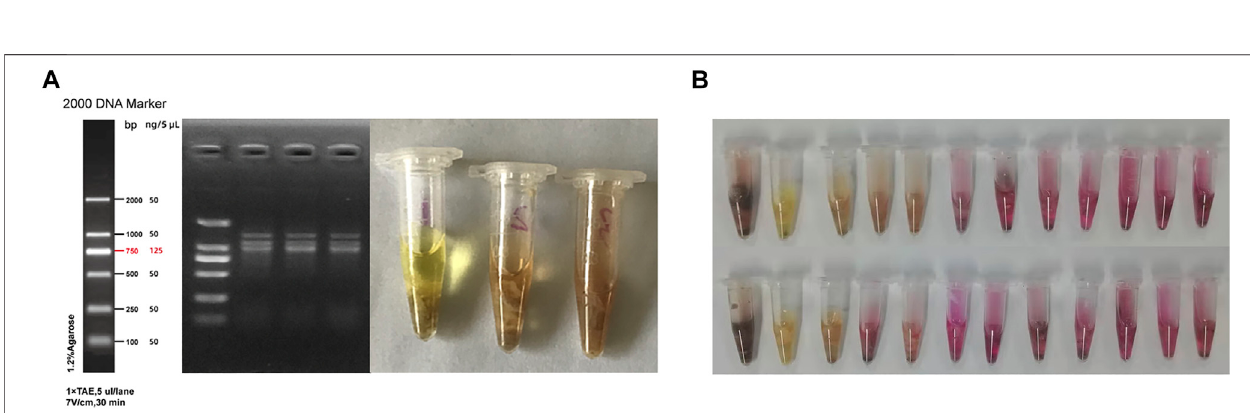
FIGURE 2 | Hp colonization in the stomach tissues of mice. (A) Results from PCR and urease test after quarantine; (B) Results of urease test in the model group after 12 weeks of modeling.